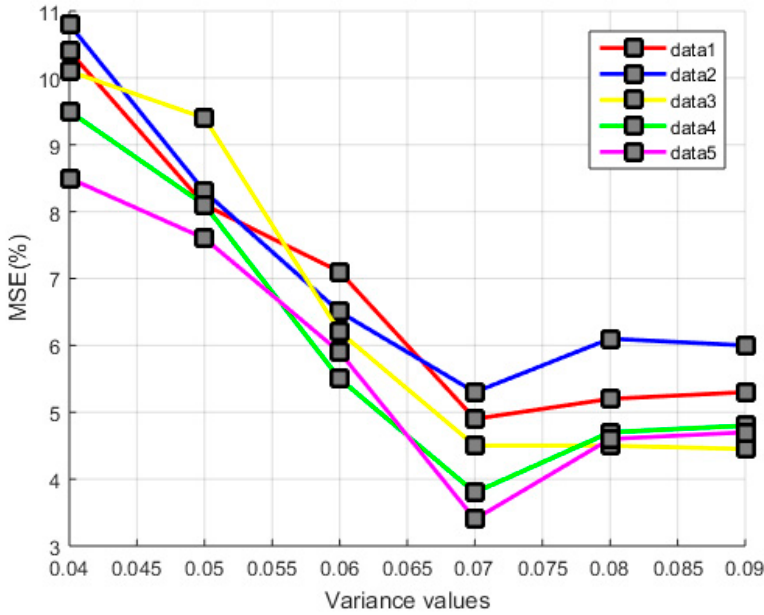
Figure 7. Diverse principal component analysis (PCA) variance values evaluation in terms of mean square error (MSE) results intended for appropriate feature selection and classification.